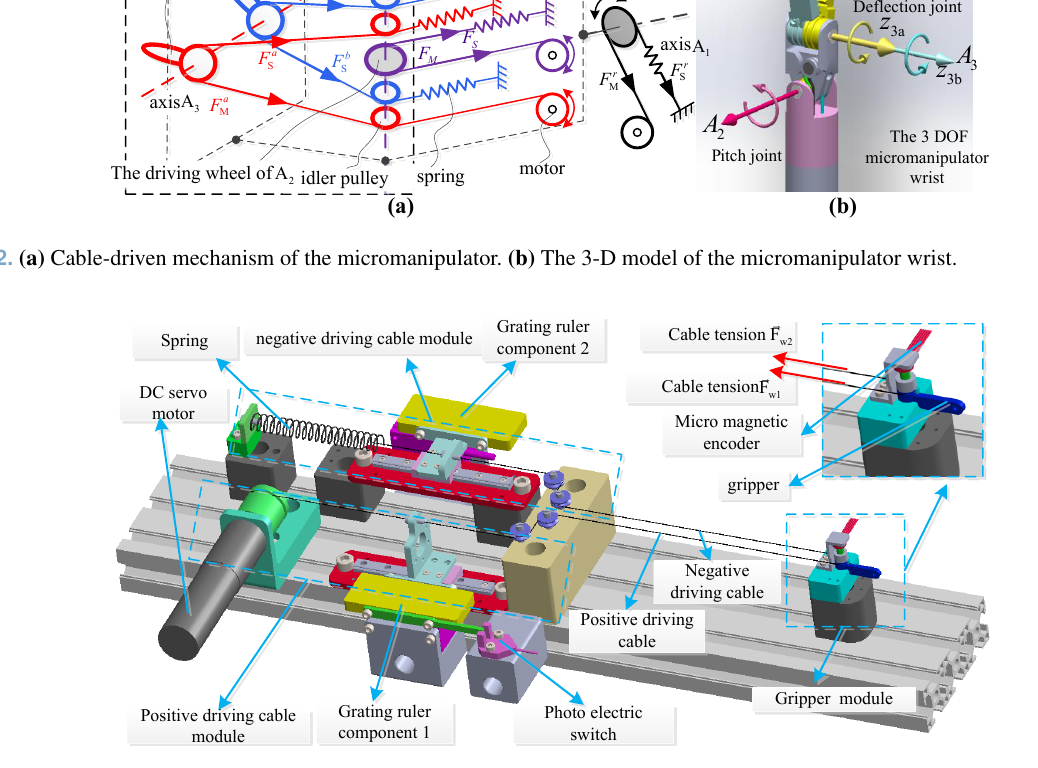
Figure 3. 3-D model of the single joint